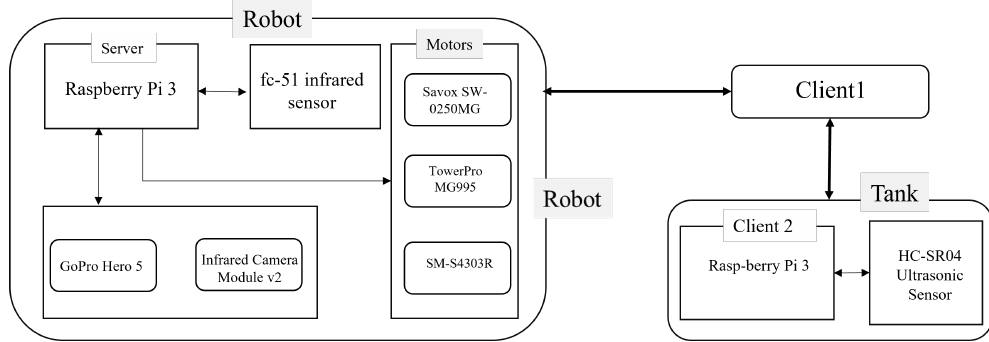
Figure 3. Hardware architecture of the developed robotic system with